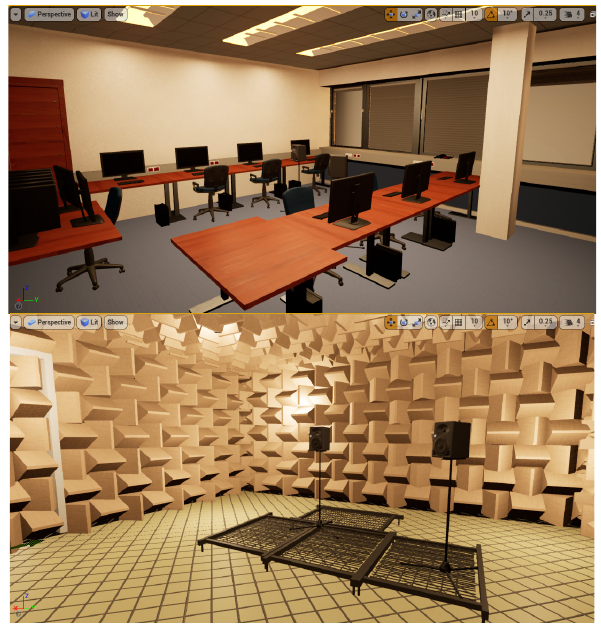
Figure 2. Simulated virtual rooms ( top : computer room; bottom : anechoic